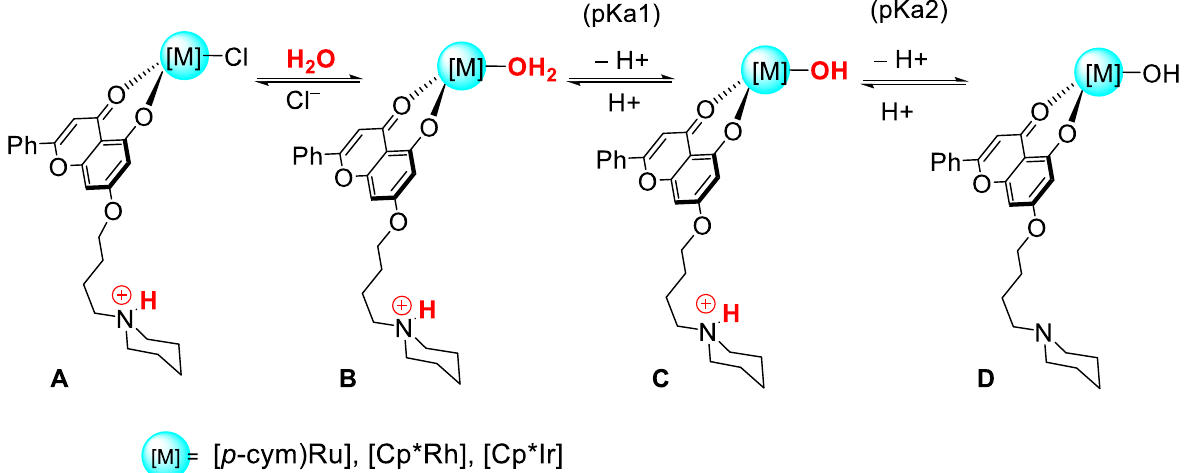
Table 3. pK a values obtained for HL4 and